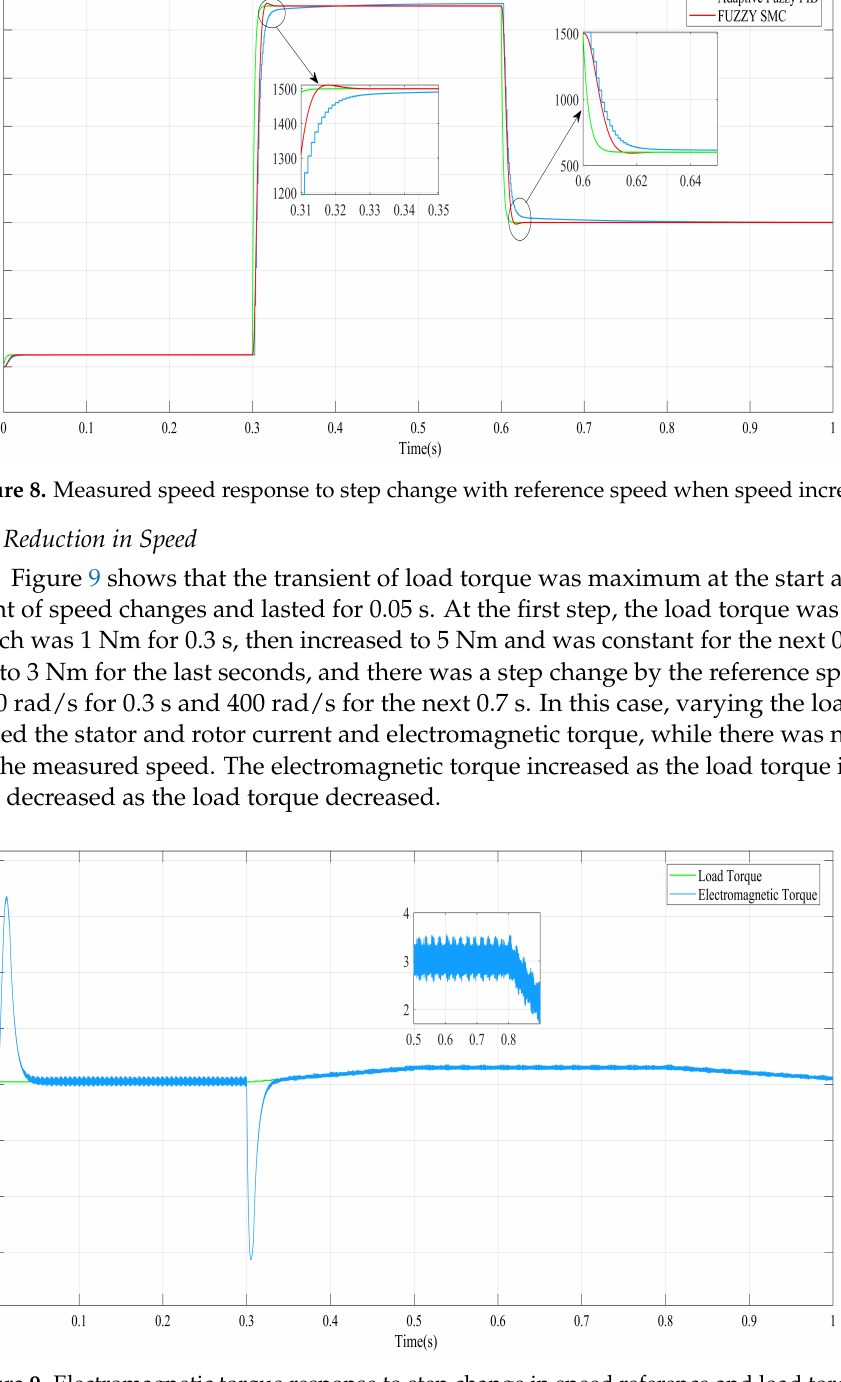
Figure 9. Electromagnetic torque response to step change in speed reference and load